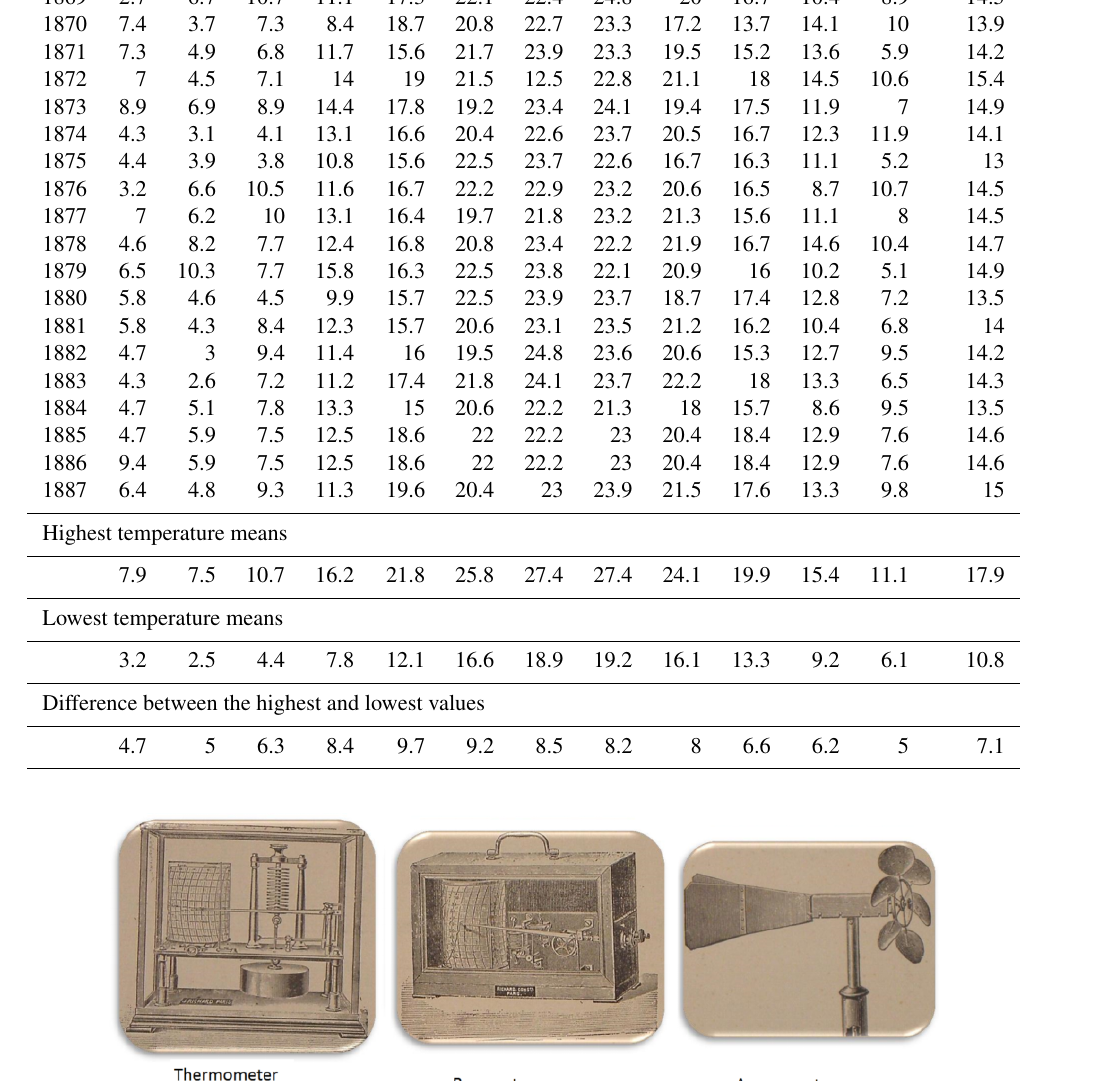
Figure 4. The instruments in the Rasathane-i